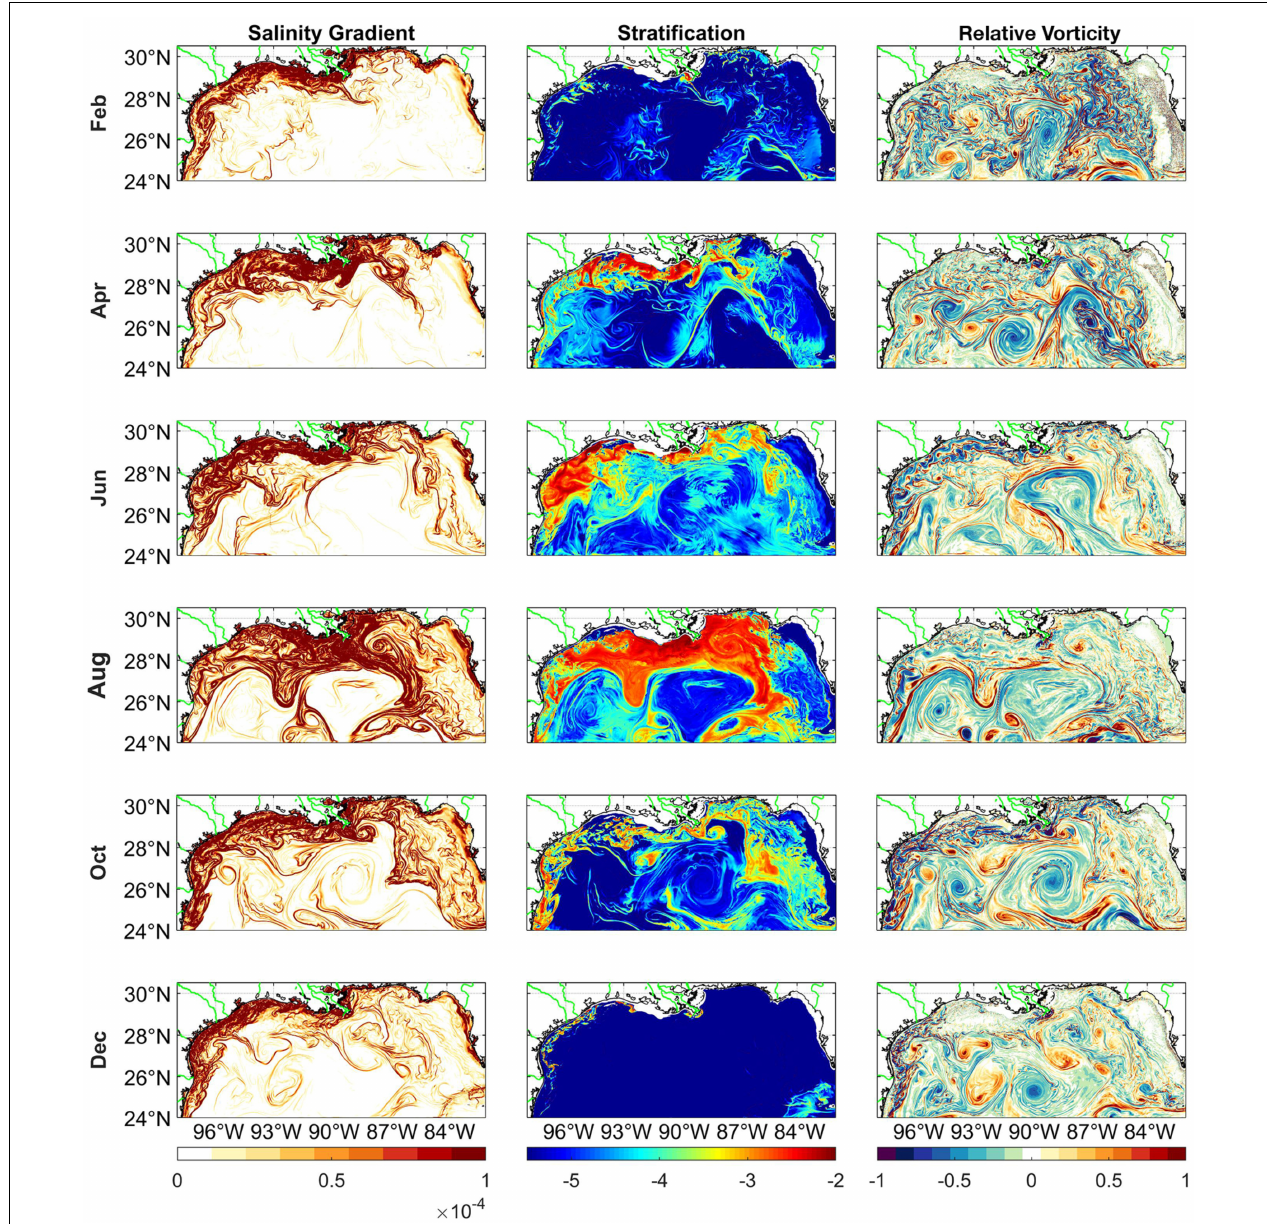
FIGURE 3 | Instantaneous fields of surface salinity gradient (m − 1 ), stratification in the upper 10 m of the water column (log scale, s − 2 ), and normalized surface relative vorticity ζ /f (unitless) in Feb, Apr, Jun, Aug, Oct, and Dec 2015. The patterns are obtained from the first ensemble member of each SP active case in the 3rd and 5th months of the (free) simulation and exemplify the dynamical characteristics of the flow field in the various